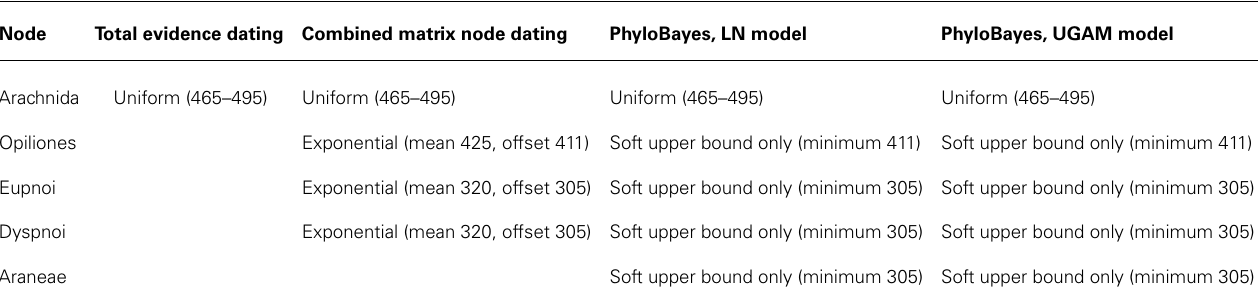
Table 1 | Priors utilized for node calibrations in molecular dating analyses. Node Total evidence dating Combined matrix node